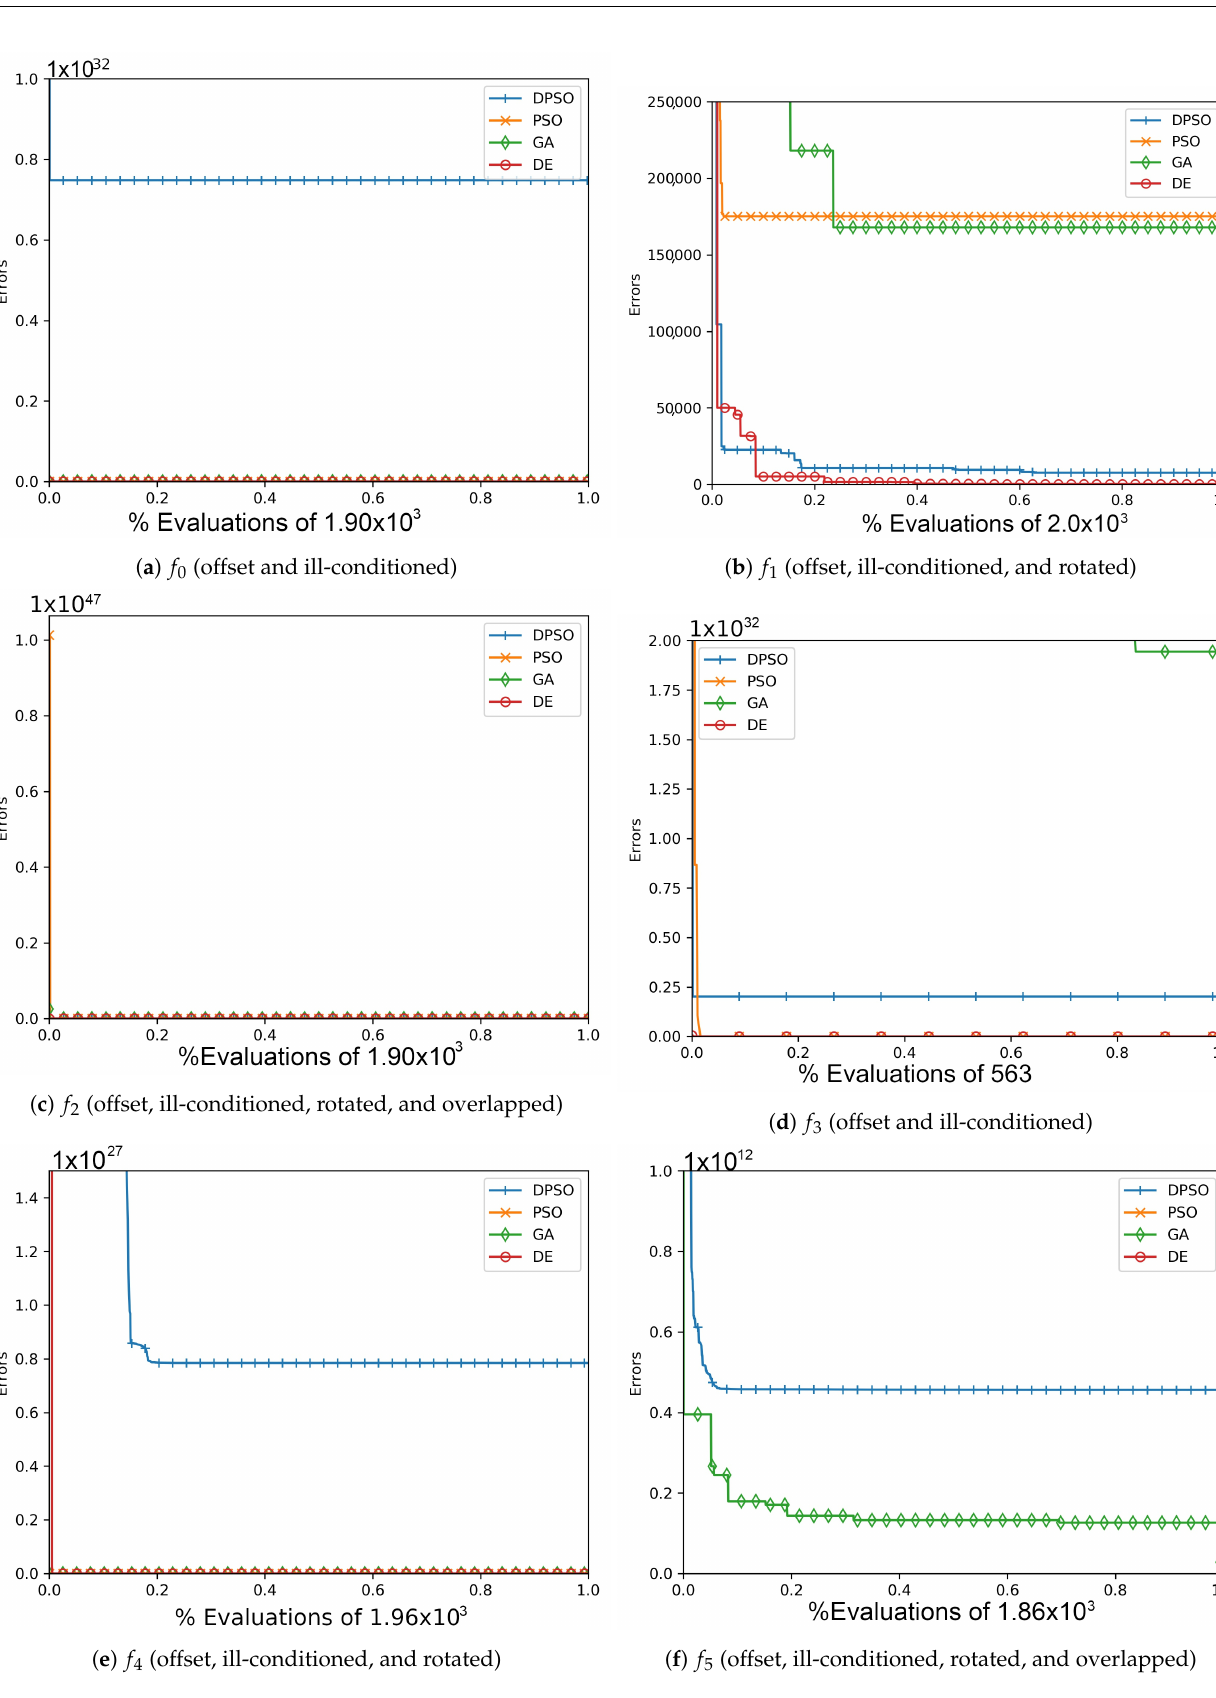
Figure A2. The average In-Sample ( f 0 , f 1 , f 2 ) and Elliptical ( f 3 , f 4 , f 5 ) global best results over time for 14